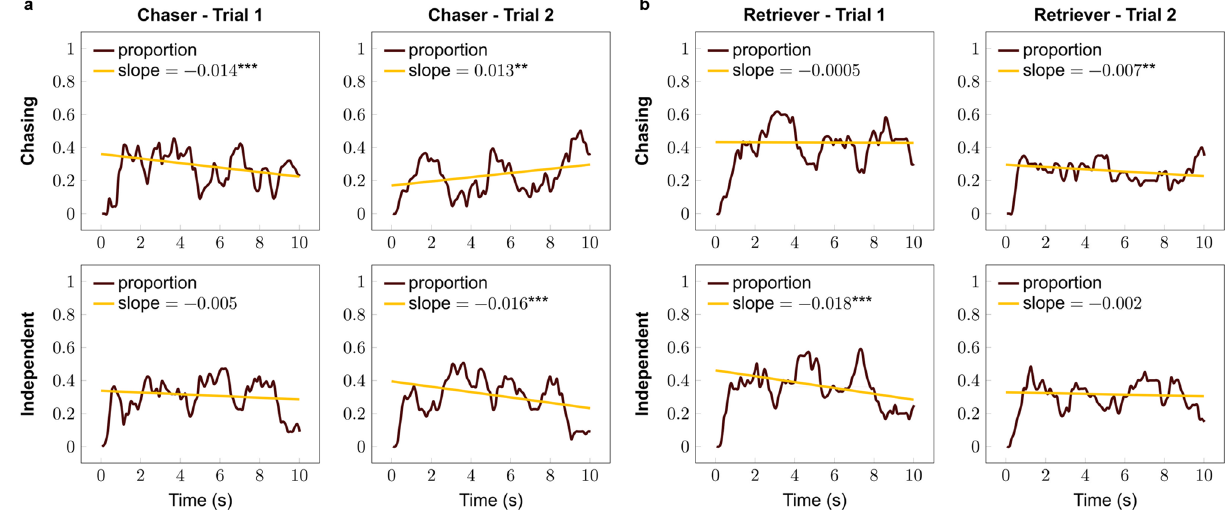
Figure 3. Proportions of looking at the chasing and independent patterns in the ( a ) chaser and ( b ) retriever groups. * p < 0.05, *** p < 0.001. Group Trial